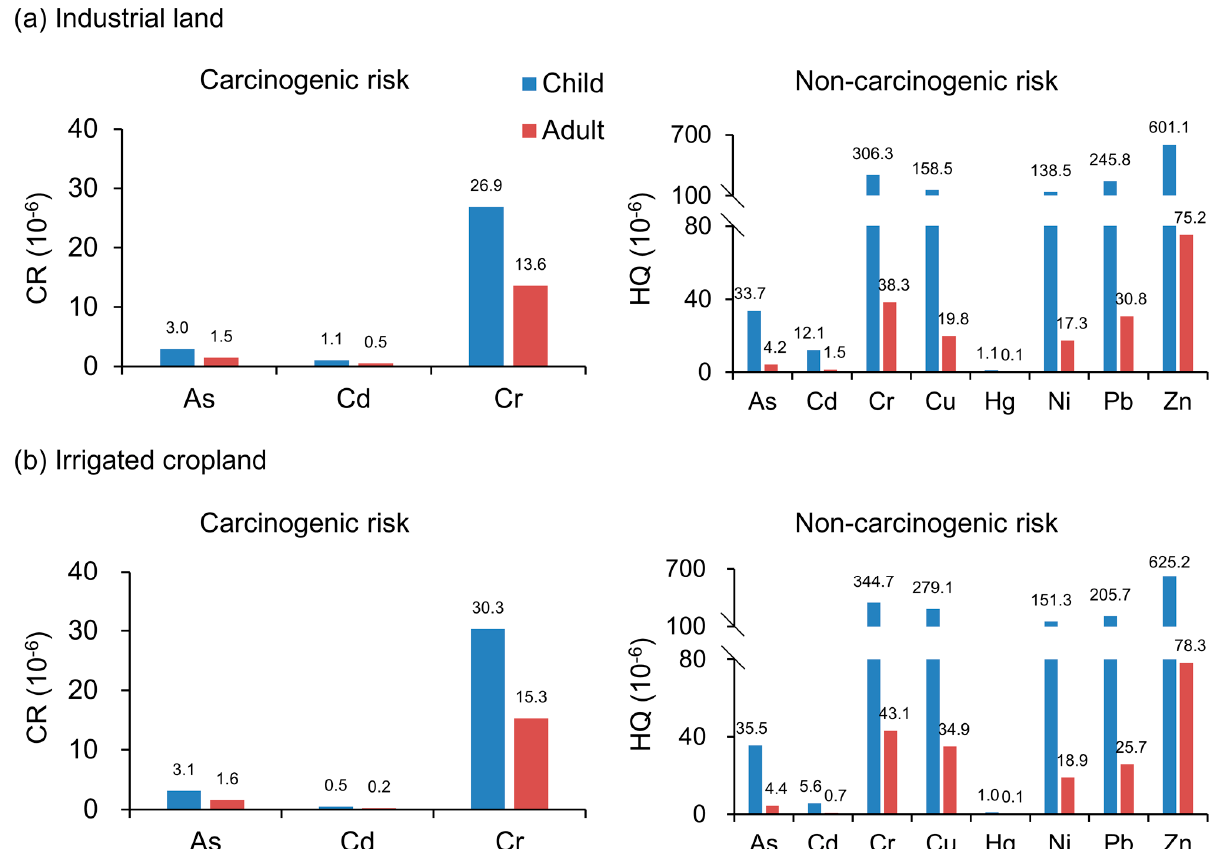
Figure 7. Health risk of different elements risk in children and adults under two land-use types. ( a ) Industrial land, ( b ) Irrigated cropland. ( a ) Industrial land, ( b ) Irrigated